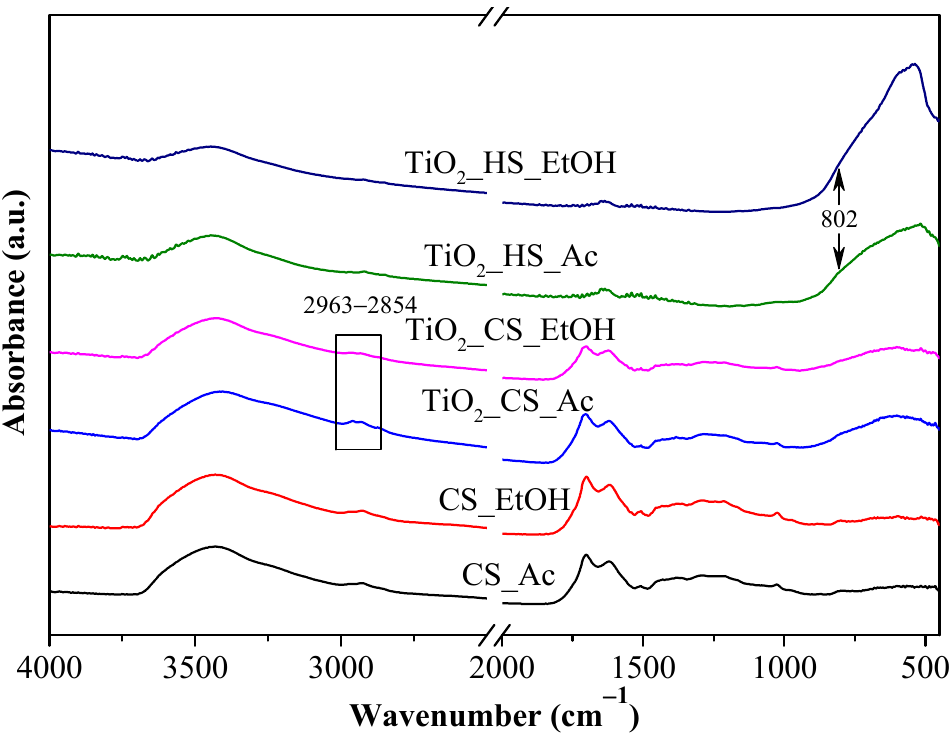
Figure 4. FT-IR spectra of the home-made CSs, CS-TiO 2 composites, and TiO 2 -HSs. In the FT-IR spectra, a broad band centered at 3400 cm − 1 was observed together with a sharp band at 1630 cm − 1 , which can be associated with adsorbed water and stretch- ing/bending vibrations of surface OH groups, respectively [24,25]. In the titania-containing samples, the bands around 540 cm − 1 correspond to Ti–O bonds [26]. Bands at 2854, 2871, 2928, and 2963 cm − 1 were more profound in TiO 2 _CS_Ac compared with TiO 2 _CS_EtOH, which were attributed to CH 2 symmetric stretching, CH 3 symmetric stretching, C–H stretching, and CH 3 asymmetric stretching vibrations, respectively [27]. Most importantly, in TiO 2 _HS_Ac, an additional band (i.e., a shoulder, partly covered by the Ti–O fingerprint region) was observed at 802 cm − 1 , compared with TiO 2 _HS_EtOH. This can be attributed to the presence of carbonate species in the TiO 2 lattice, which is characteristic of carbon- modified crystalline titania [28–30]. Based on these measurements, a plausible explanation was proposed for the differences that were observed between the TiO 2 -HS